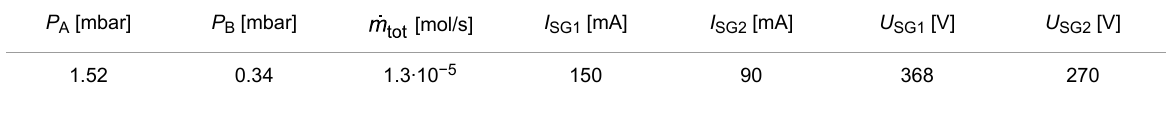
Table 1: Optimized operating conditions and synthesis parameters used for the production of CS-NPs described in the present study. P A [mbar]